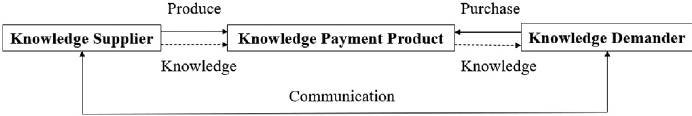
Figure 1. Actions and direction of knowledge fl ow in knowledge